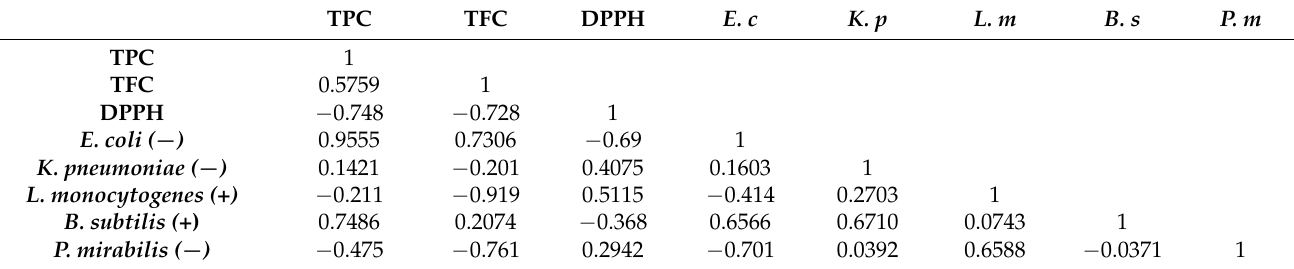
Values represent means ± SD (standard deviation). Values with similar letters in each column are not significantly different ( p < 0.05; n = 3). 3.4. Correlation of TPC, TFC, Antiradical, and Antimicrobial Activity Phenolics and flavonoids of plant extracts can be related to the antioxidant activi- ties. There was a significant correlation between TPC and TFC, for both E1 and E2 , with Pearson’s correlation coefficients of r = − 0.748 and r = − 0.728, respectively (Table 3). Table 3. Correlation of TPC, TFC, antiradical, and antimicrobial